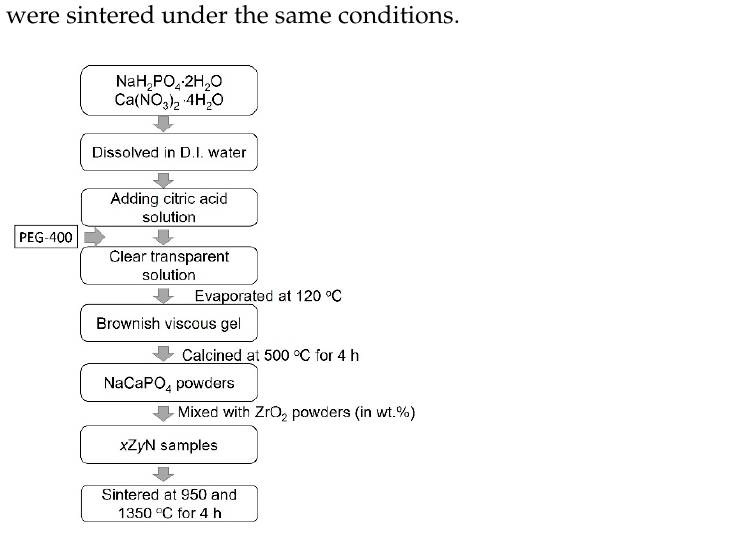
Figure 1. Flow chart of sample preparation procedures conducted in this study.